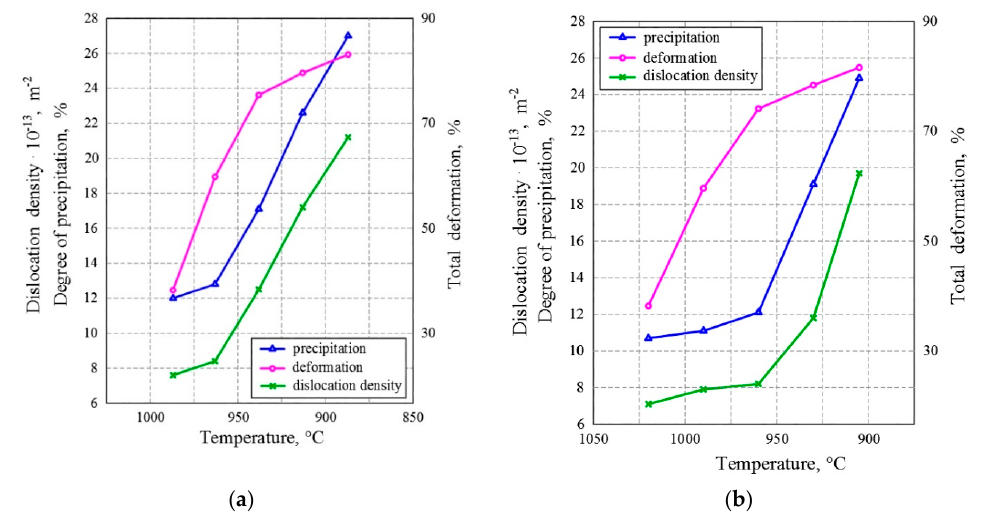
Figure 7. Relation between the degree of precipitation, the dislocation density, and temperature for ( a ) the LT variant and ( b ) the HT variant.